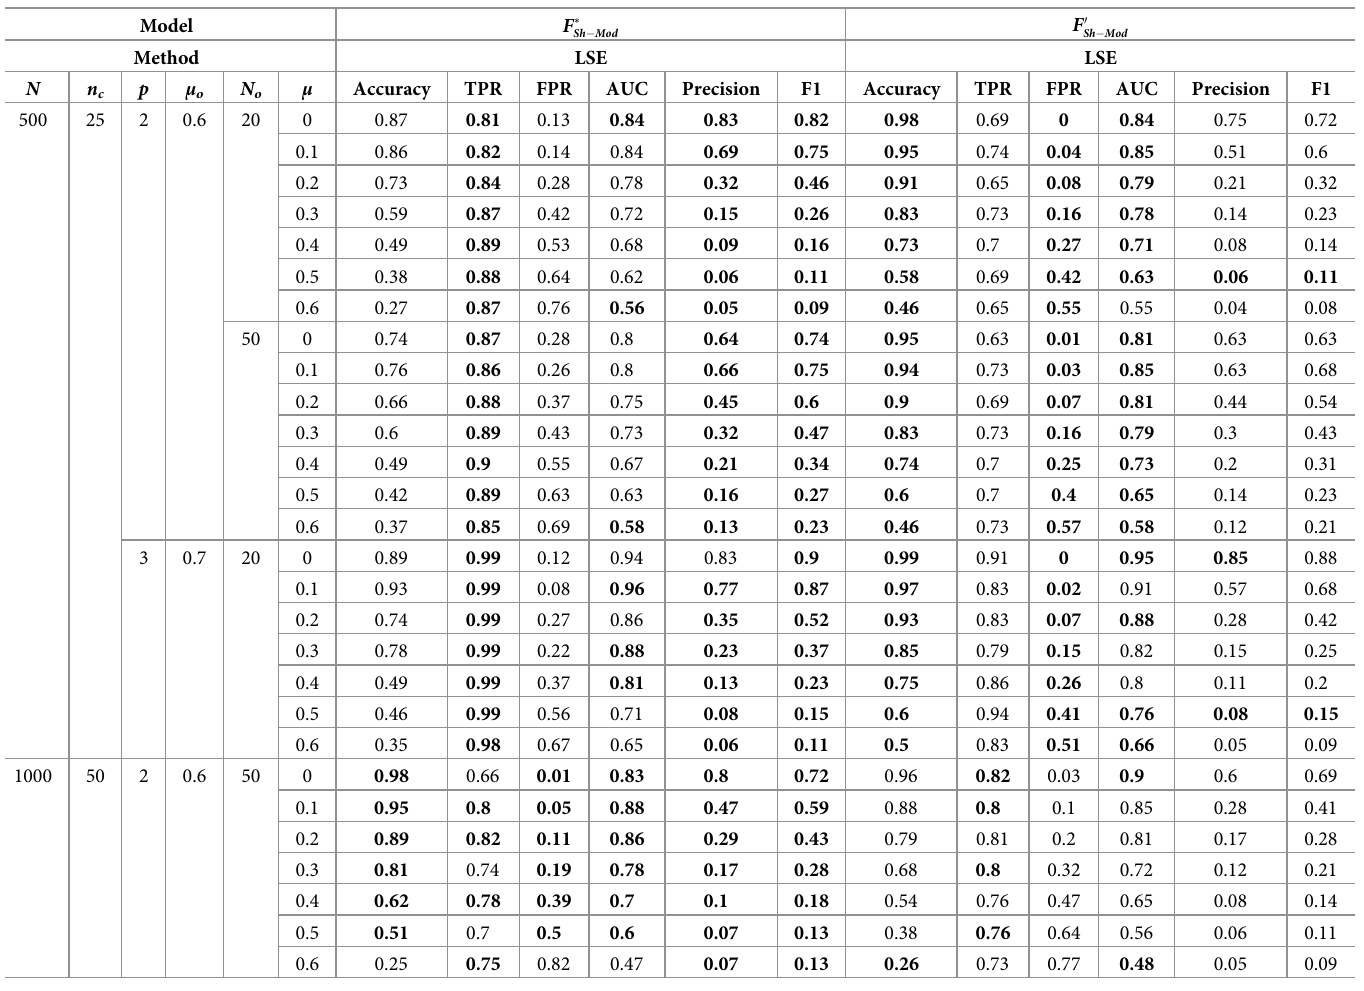
Table 5. Computational results about large-scale networks with overlapping communities.